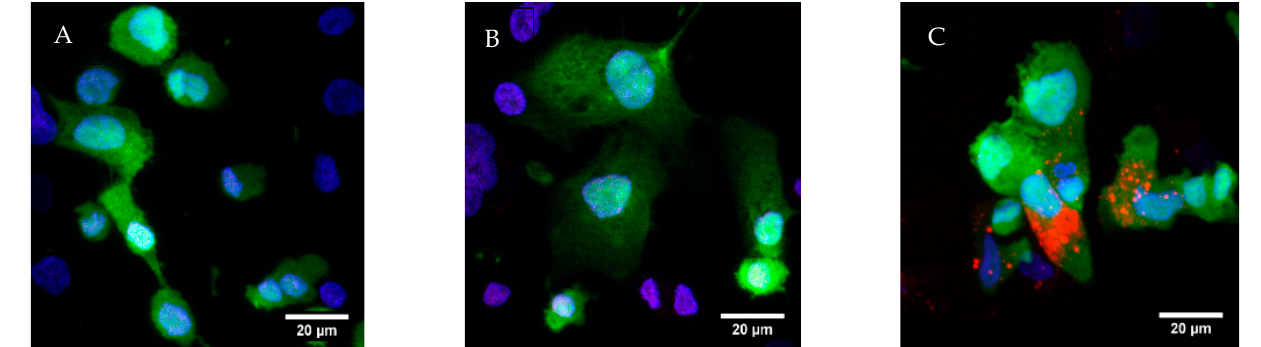
Figure 3. Confocal microscopy images of cellular uptake and distribution of ATRA-Rhodamine co- loaded PLGA NPs treatment for 24h. THP-1 differentiated macrophages were treated with ( A ) RPMI, ( B ) blank PLGA NPs, and ( C ) ATRA-Rhodamine co-loaded PLGA NPs (red) and viewed 24 h later using confocal microscopy (Carl Zeiss, Jena, Germany) at 40×. Hoechst (blue) stains nuclei, HCS CellMask™ Green (green) stains cytoplasm. Scale bar: 20 μ m.